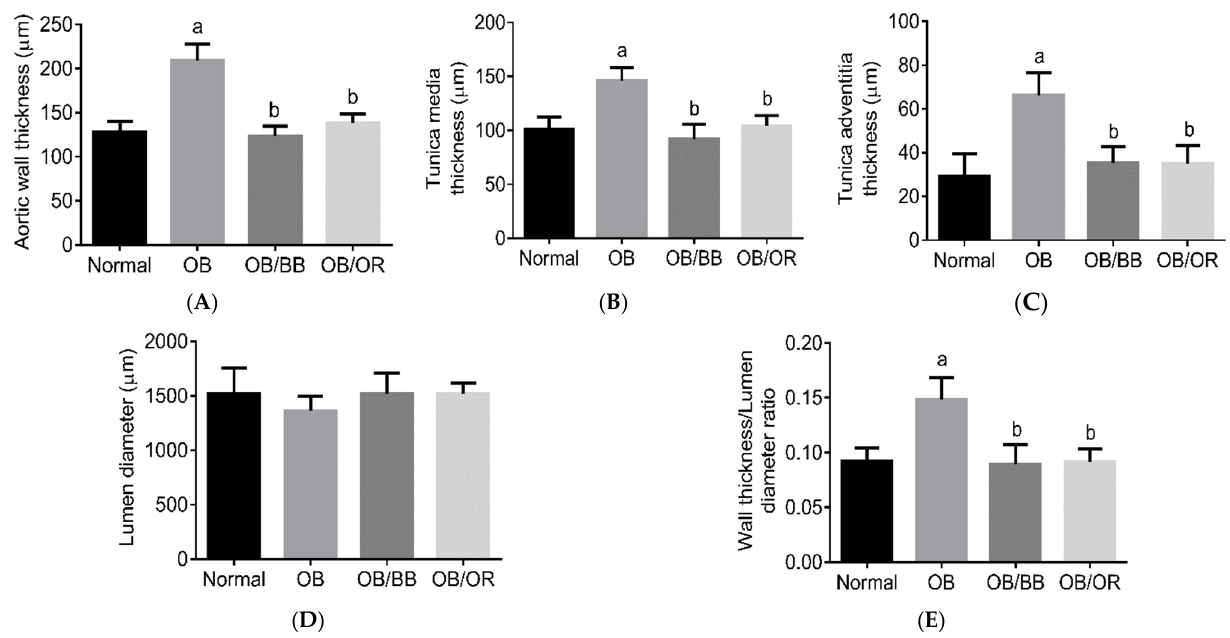
Figure 5. Morphometric analysis of H&E stained aorta from each experimental group. Values are mean and standard deviation, n = 10/group. Thickness of ( A ) aortic wall, ( B ) tunica media, and ( C ) tunica adventitia, ( D ) lumen diameter and ( E ) ratio of wall thickness per lumen diameter of the thoracic aorta. OB: obese, OB/BB: obese and bee bread 0.5 g/kg/day, OB/OR: obese and orlistat 10 mg/kg/day. a p < 0.05 compared to normal group, b p < 0.05 compared to the OB group. All data were analyzed using one-way ANOVA followed by Tukey’s post hoc test.